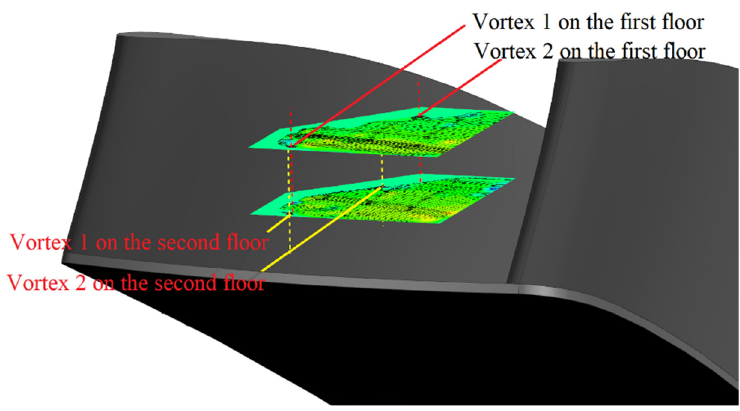
Figure 13. Schematic of the shooting location.